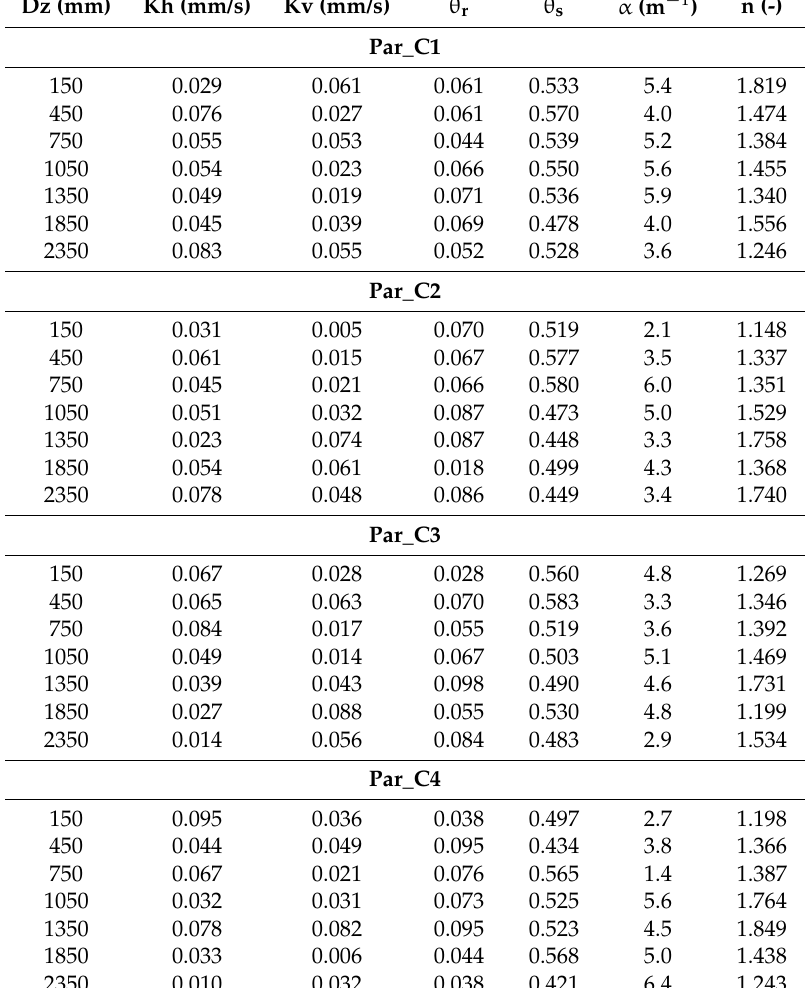
Table 1. Optimal parameter sets for the four locations estimated by using the LUCa calibration algorithm. Dz (mm) is the depth of each soil layers from ground level, Kh and Kv (mm/s) are the lateral and the vertical hydraulic conductivities, respectively, θ r and θ s (m 3 ¨ m ´ 3 ) are the residual and saturated water contents, respectively, and α (m ´ 1 ) and n are the van Genuchten